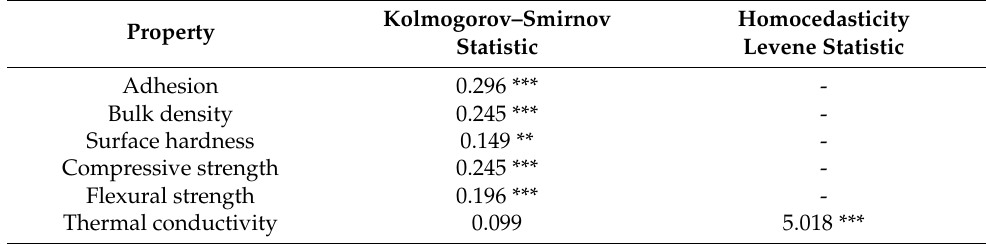
Table 7. Suitability of assumptions for ANOVA analysis. Property